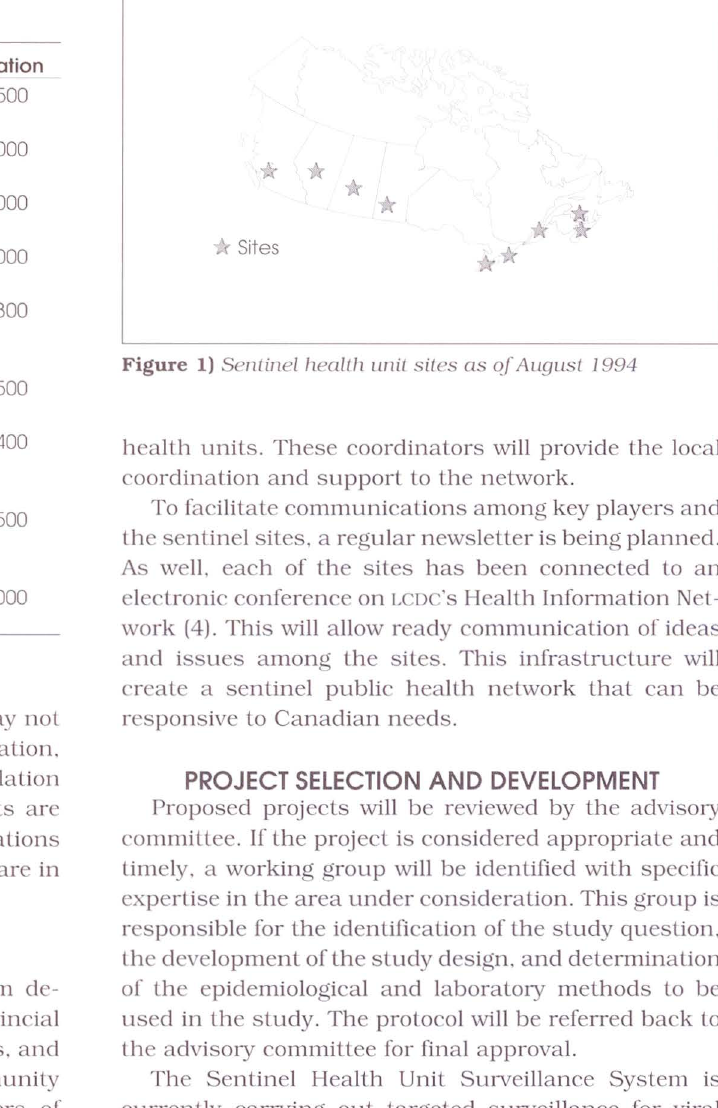
Summary of participating health units